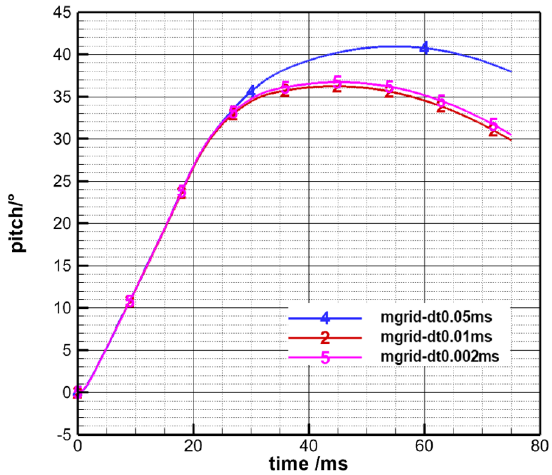
Figure 9. Time independency verification.